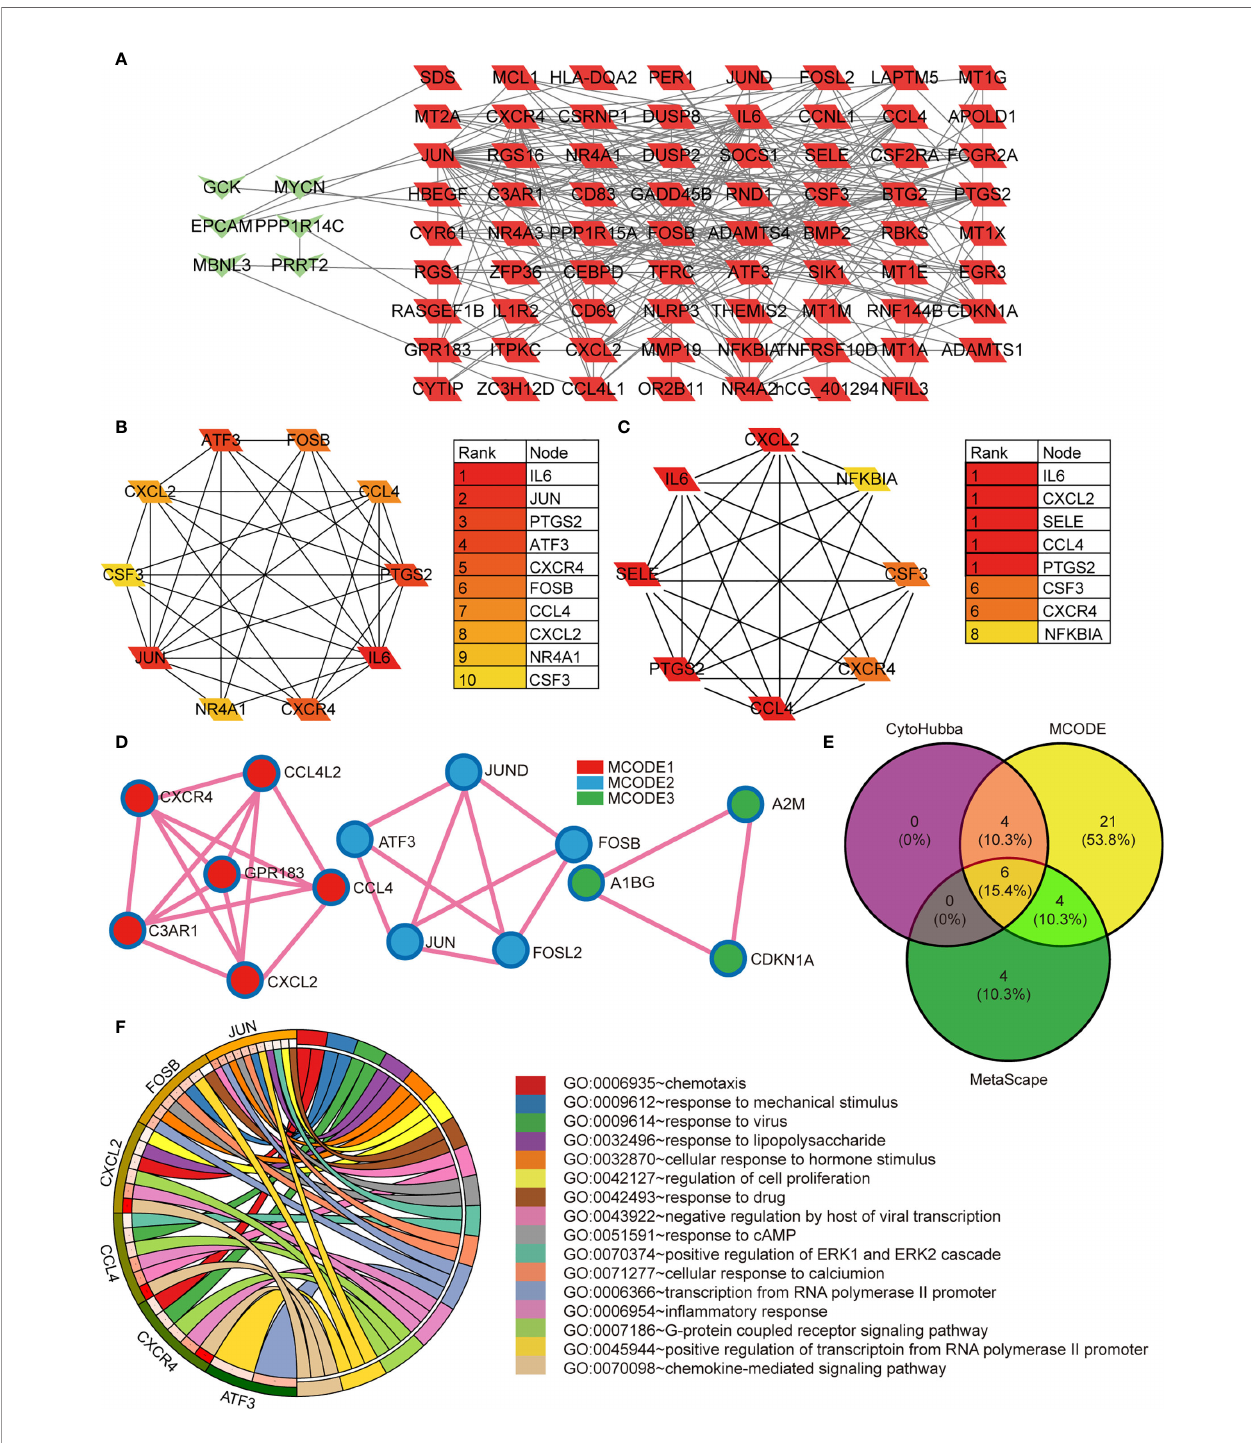
FIGURE 2 | (A) The protein-protein interaction network constructed based on the DEGs. The green heart represents the downregulated genes, the red parallelogram represents the upregulated genes. (B – D) The hubgenes predicted by cytohubba, Mcode, and metascape Mcode, respectively. (E) Overlap of hubgenes identi fi ed via the three methods; (F) The Pathway analysis results showing the six enriched